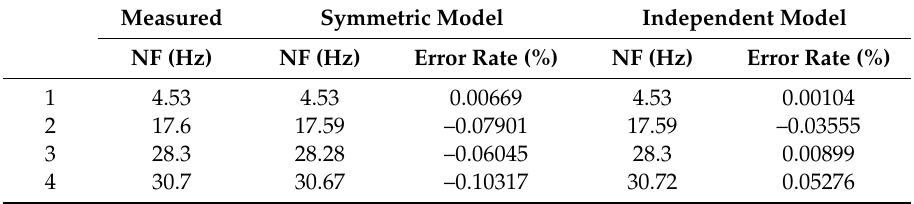
Table 1. Natural frequencies in the undamaged state [45] and the corresponding updated results.